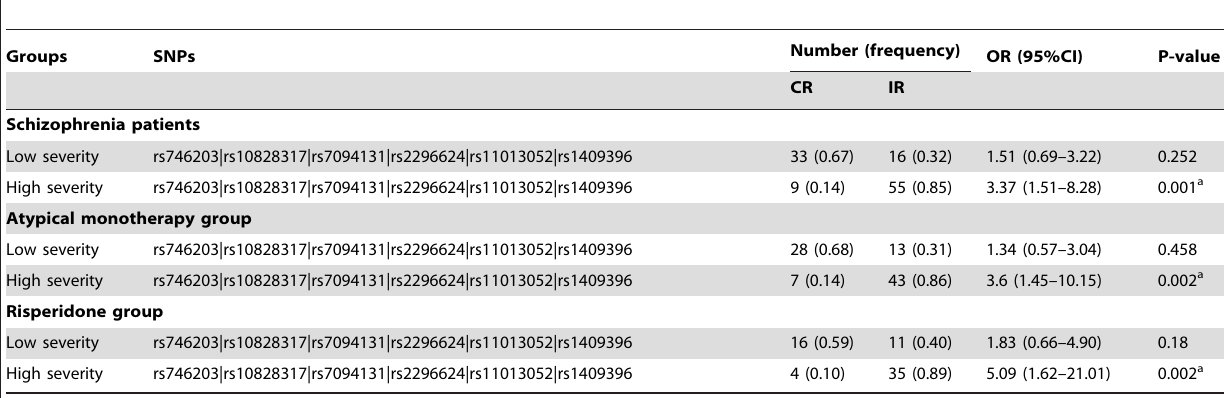
Table 6. Distribution of diplotype, ATTGCT/ATTGCT ( PIP4K2A ) and its association analysis with drug response in schizophrenia patients (n =423), atypical monotherapy (n=355) and risperidone group (n=260).